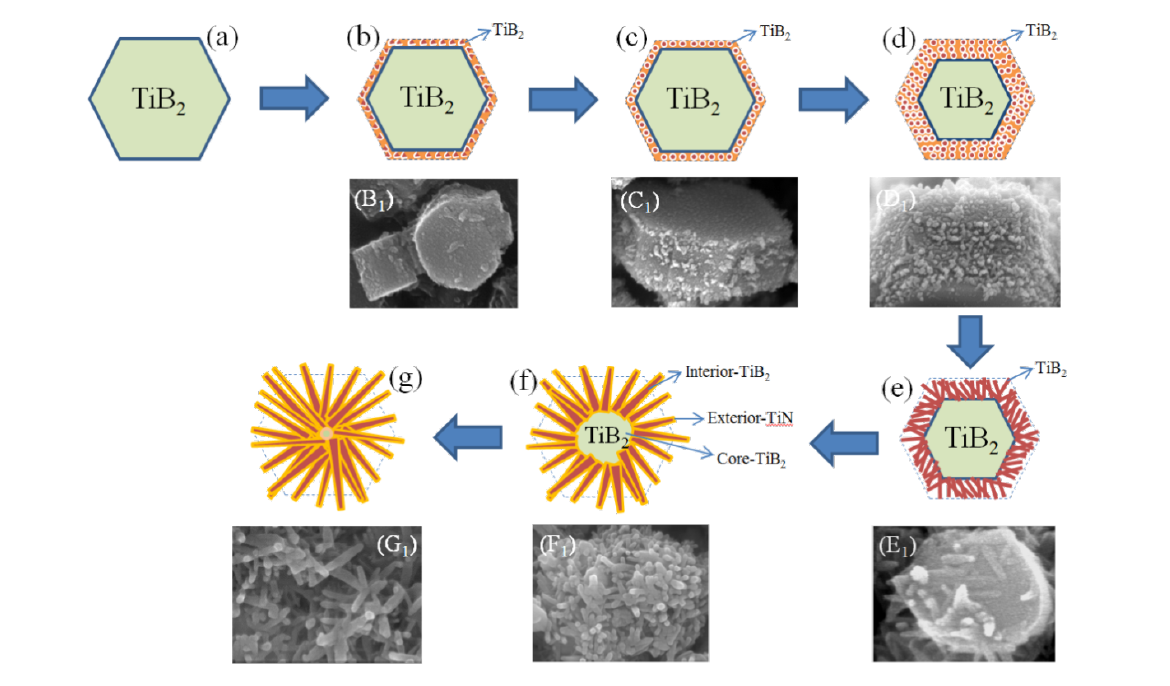
Figure 4: Proposed schematic illustration and the corresponding FSEM images related to the formation process of the as-synthesized TiB 2 /(TiB 2 –TiN) samples. (a) TiB 2 hexagonal prism crystal. (b) (B 1 ) The surface layer was broken into fragments. (c) (C 1 ) TiB 2 fragments melted into small droplets. (d) (D 1 ) Small droplets self-assembled into bubble-like short chains. (e) (E 1 ) Bubble-like short chains transformed into nanorods. (f) (F 1 ) TiN formed on the surface on the nanorods. (g) (G 1 ) TiB 2 /(TiB 2 –TiN) hierarchical/heterostructured nanocomposites are the resulting